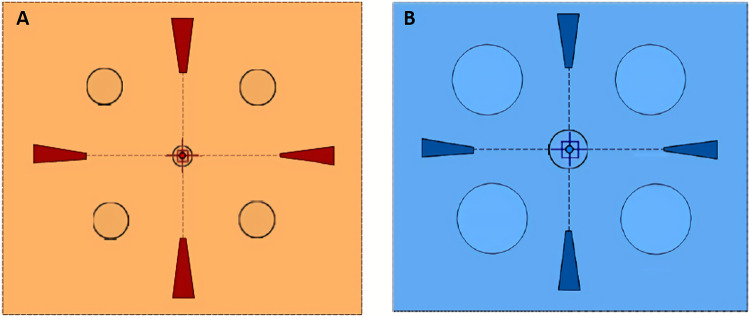
Background display for cone and rod-enhanced stimulus conditions.The left panel shows the approximate appearance of the visual display when showing the cone-enhanced stimulus. The stimulus is displayed either at the centre or at an eccentricity of 5° (away from fixation), diagonally in each of the four quadrants. The real stimulus is a borderless disc, modulated sinusoidally and presented at equal luminance. The right panel illustrates the appearance of the rod-enhanced stimulus condition. The subject views the display through a 1.0 log unit neutral density filter to ensure reliable display performance at 0.5 cd/m2. Preliminary experiments show that the measured rod thresholds do not change significantly when the time for background adaptation is extended from 1 to 16 minutes.